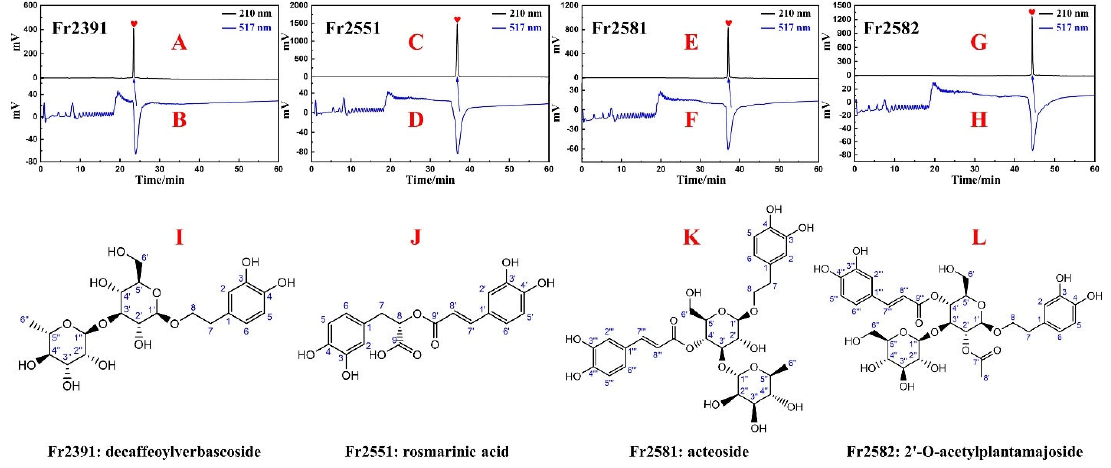
Figure 6. Chromatograms of Fr2391 ( A , B ), Fr2551 ( C , D ), Fr2581 ( E , F ) and Fr2582 ( G , H ) after separation on a ReproSil ‐ Pur C18 AQ analytical column, and showing their purity levels as well as DPPH inhibitory activities. The chemical structures of Fr2391 ( I ), Fr2551 ( J ), Fr2581 ( K ), and Fr2582 ( L ) are also shown .